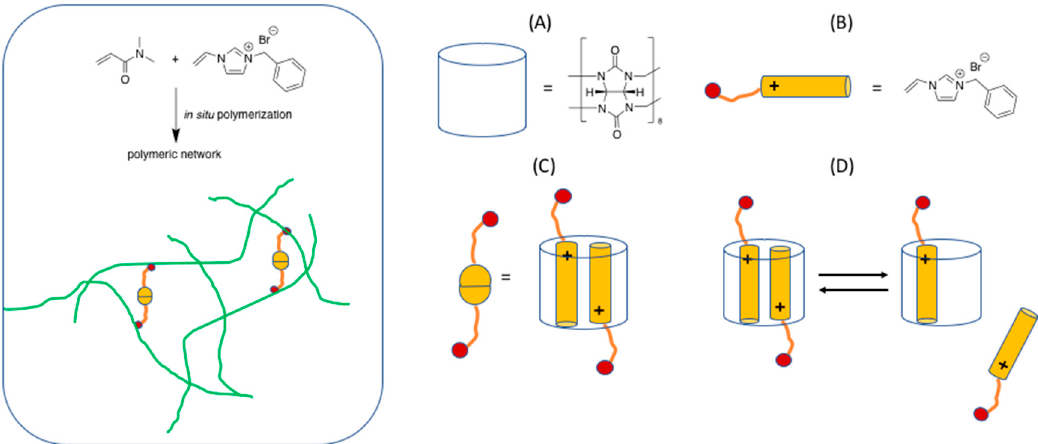
Figure 9. Adapted and re-drawn from [43]. Insert: green denotes the polymeric network. Yellow/orange structure: see ( B , C ). ( A ) chemical structure of host ( B ) chemical structure ( C ) host guest coupling ( D ) dynamic equilibrium for reversible crosslinking. Di-methylacrylamide is used here as an example of a monomer that can be used.